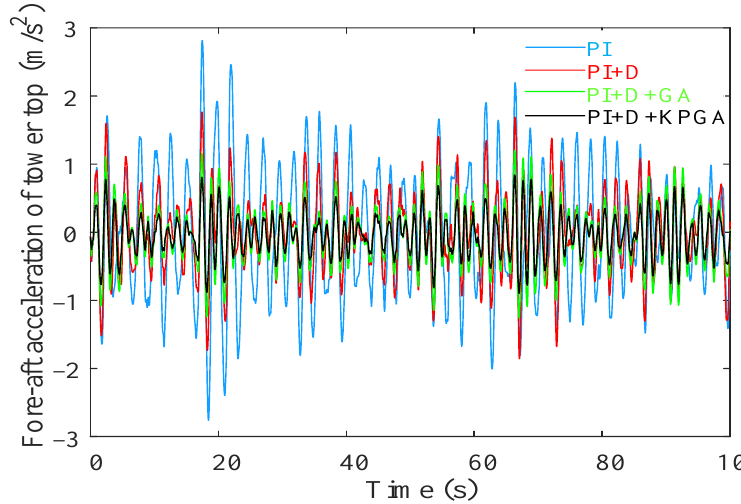
Figure 16. Change curve of fore-aft acceleration for the tower top.